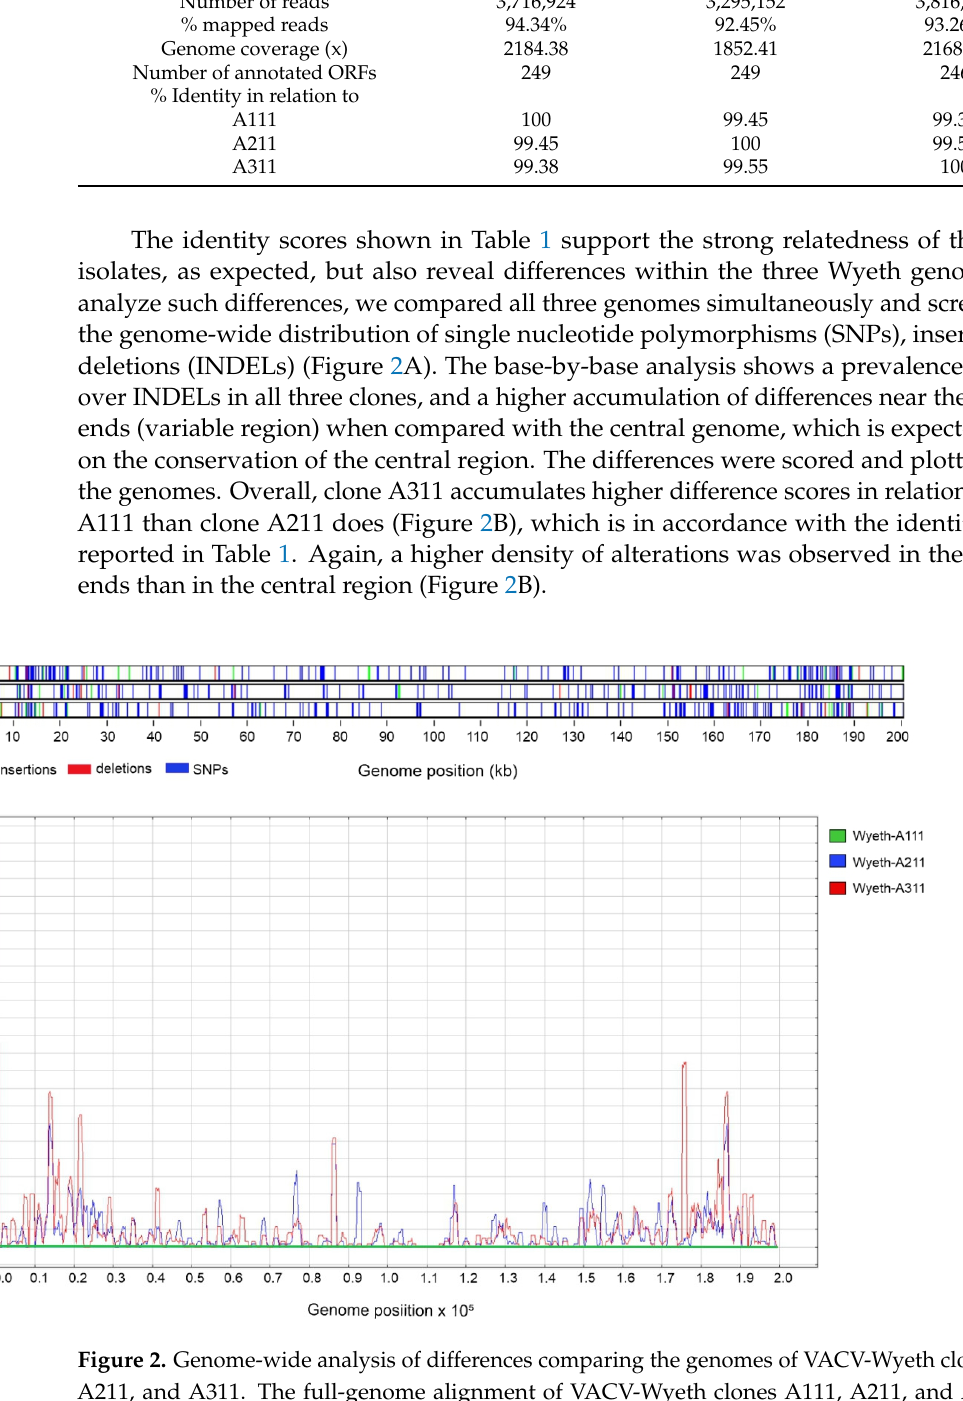
Table 1. Genomic features of the genomes of VACV-Wyeth clones A111, A211, and A311.